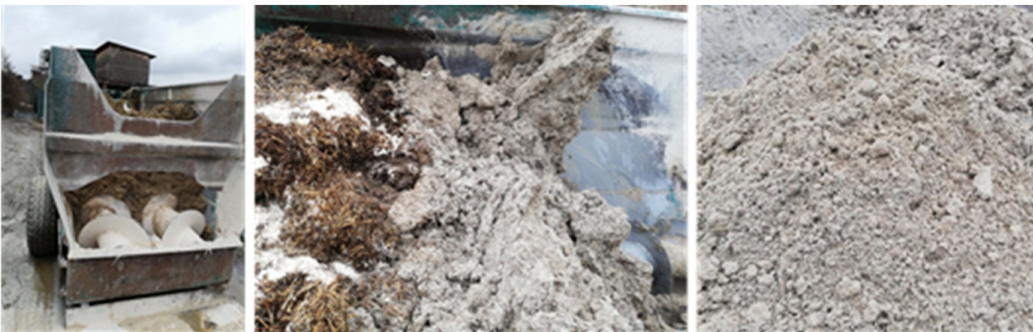
Figure 4. Production of recycled manure solids for bedding. From left: Manure collection in stall, solid liquid separation, fresh separated manure soil, recycled manure soil. Photo by Zigo F. (2019).